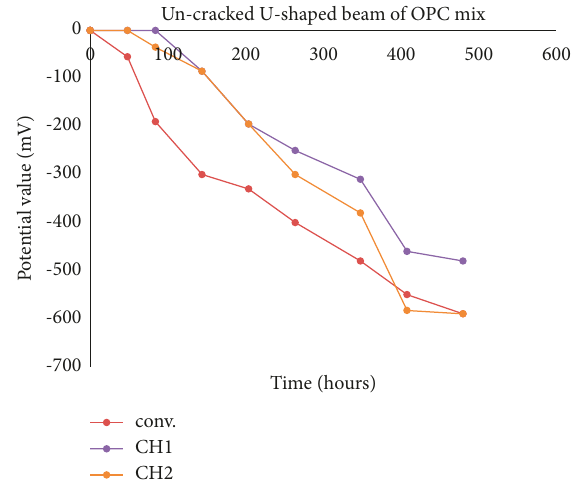
Figure 11: Uncracked U-shaped beam of OPC